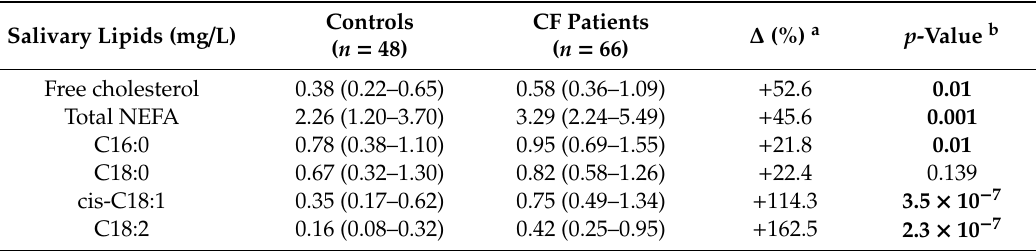
Table 2. Comparison of salivary free cholesterol and non-esterified fatty acid (NEFA) levels in controls and adult patients with